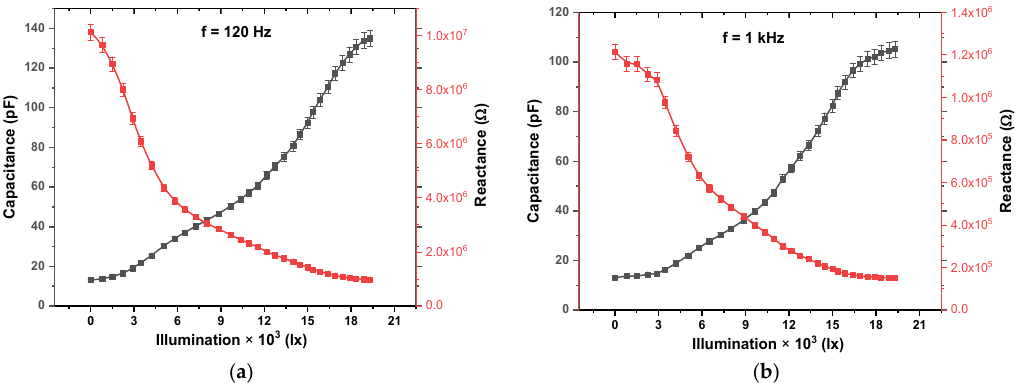
Figure 10. Capacitance and reactance–light relationships of Ag/PAD/Ag sensor at ( a ) 120 Hz and ( b ) 1 kHz.